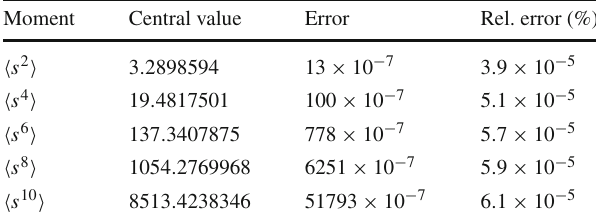
Table 3 First elementary moments for μ = 1 .